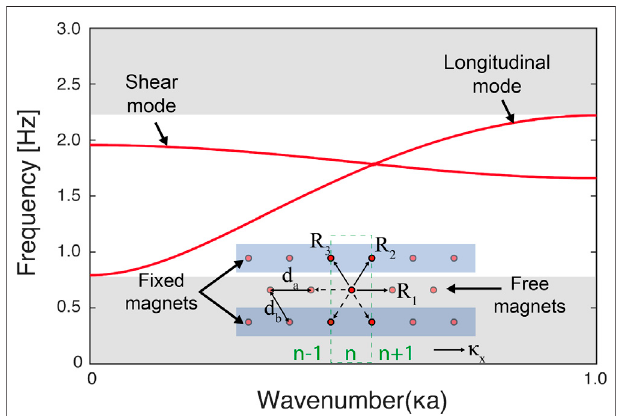
FIGURE 2 | Dispersion curves. Numerical dispersion curves for both the shear and longitudinal modes for a lattice with a (cid:2) 15 . 4 mm , b (cid:2) 24 . 5 mm and m (cid:2) 0:118 g . The band gaps are shaded in gray. The inset shows a unit cell n along with its lattice